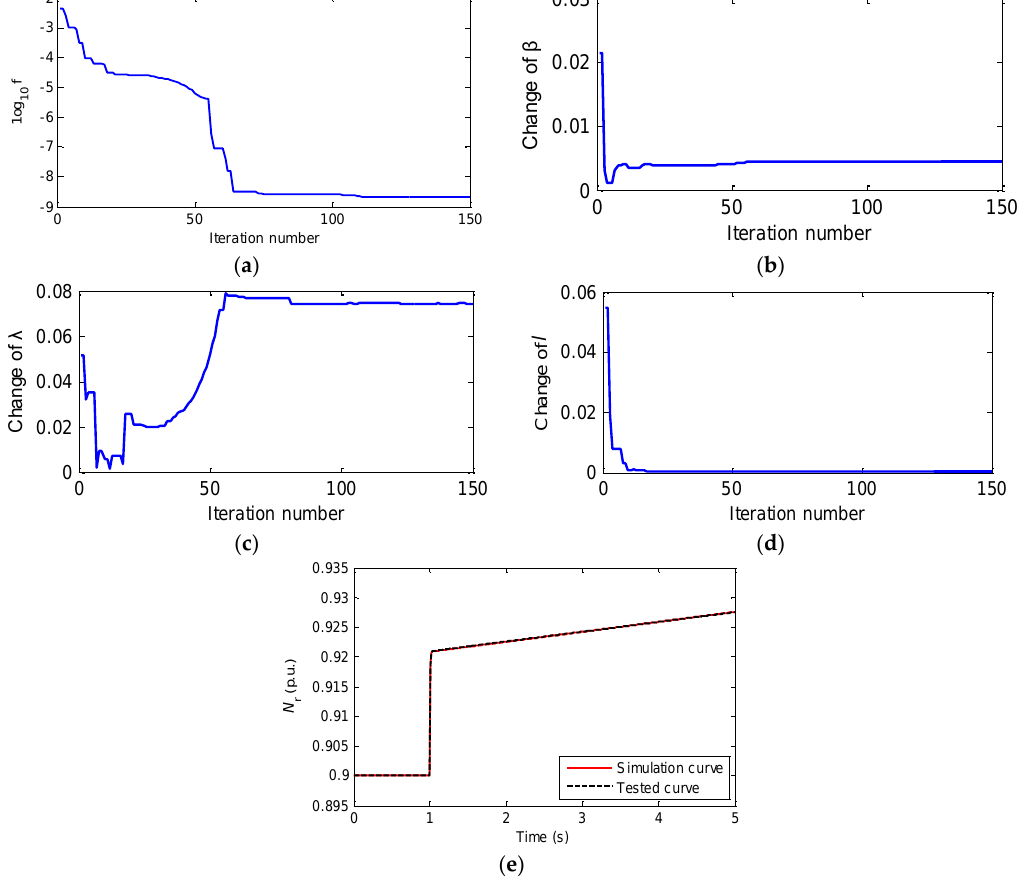
Figure 8. Core neutron dynamic module simulation comparison. ( a ) Fitness function change with optimization iterations; ( b ) change of β with optimization iterations; ( c ) change of λ with optimization iterations; ( d ) change of l with optimization iterations; and ( e ) simulation comparison of N r .